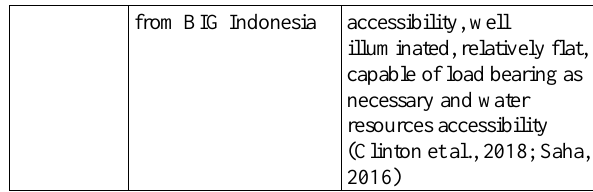
Table 2. Identifying and mapping potential urban farming areas 2.3.3